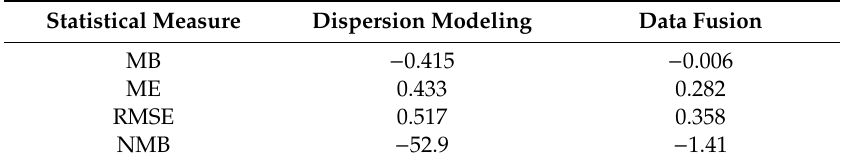
Table 3. Comparison of performance measures for dispersion modeling and data